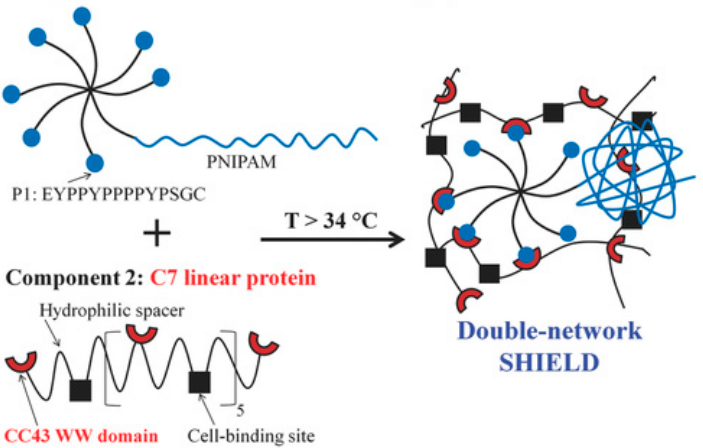
Figure 14. Schematic of a two-component double network “SHIELD”, where component 1 is an 8-arm PEG with 1 arm conjugated with PNIPAAm and the other 7 arms conjugated with proline-rich peptide (denoted as P1) domains. Component 2 is a recombinant C7 linear protein copolymer bearing CC43 WW (denoted as C) domains and RGD (arginine-glycine-aspartic acid) cell-binding domains connected by hydrophilic spacers. The formation of double network occurs via peptide recognition and collapse of thermo-responsibe PNIPAAm chains. Reprinted with permission from [165]. Copyright 2016 John Wiley and Sons.